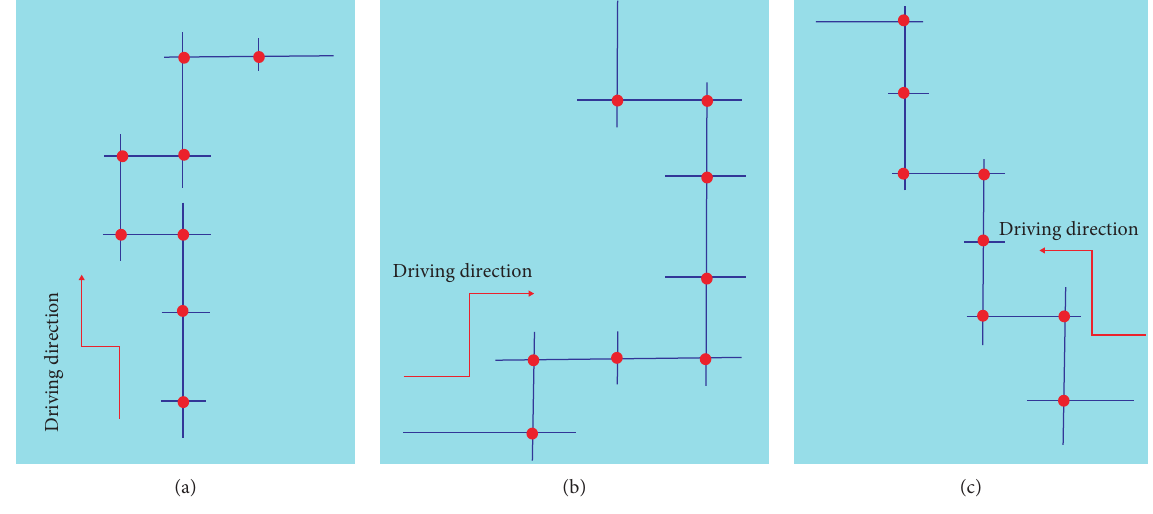
Figure 3: Driving routes of each scenario. (a) Route 1. (b) Route 2. (c) Route 3.